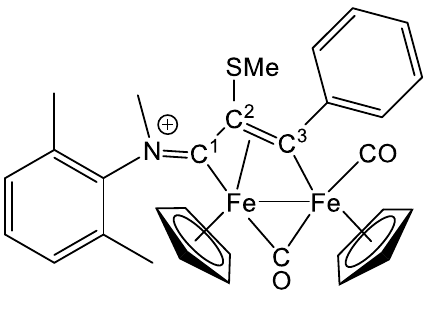
Chart 8. Structure of the cation of 5b .